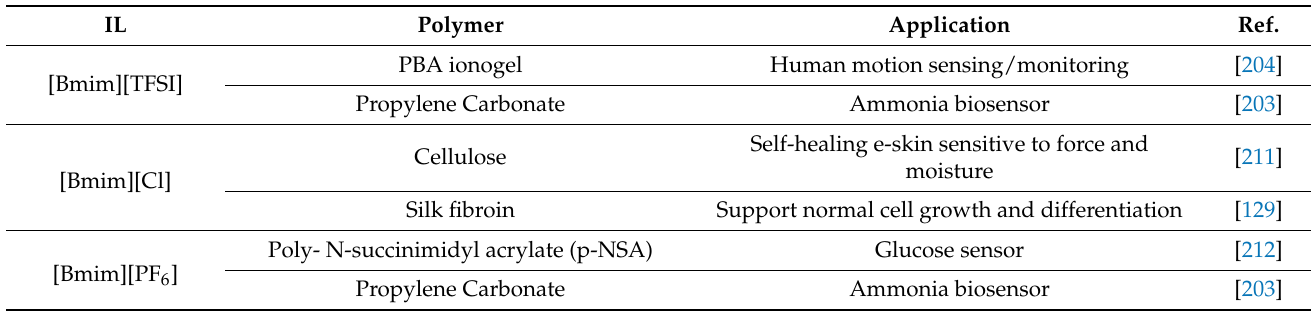
Table 5. IL-based biosensing materials for biomedical applications.